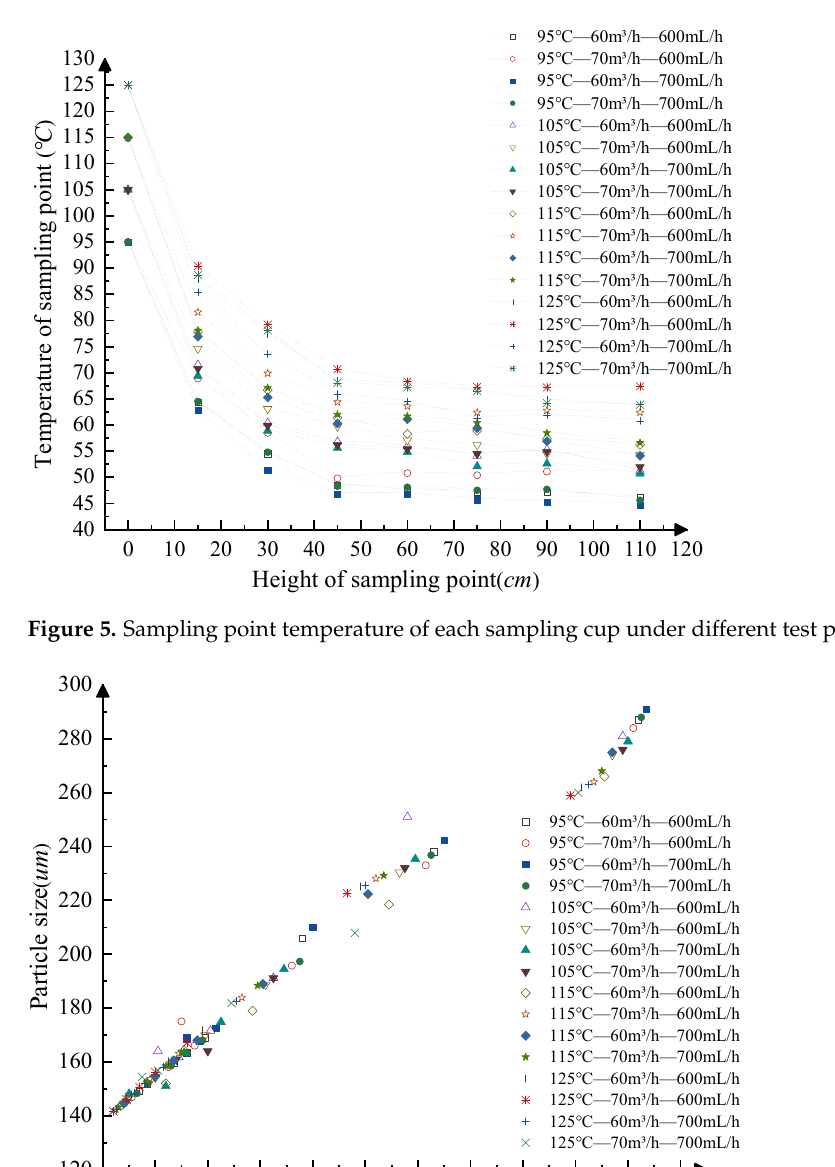
7 of 23 Table 1. Test variable group setting and representative pattern. Inlet Hot Air Temperature (°C)